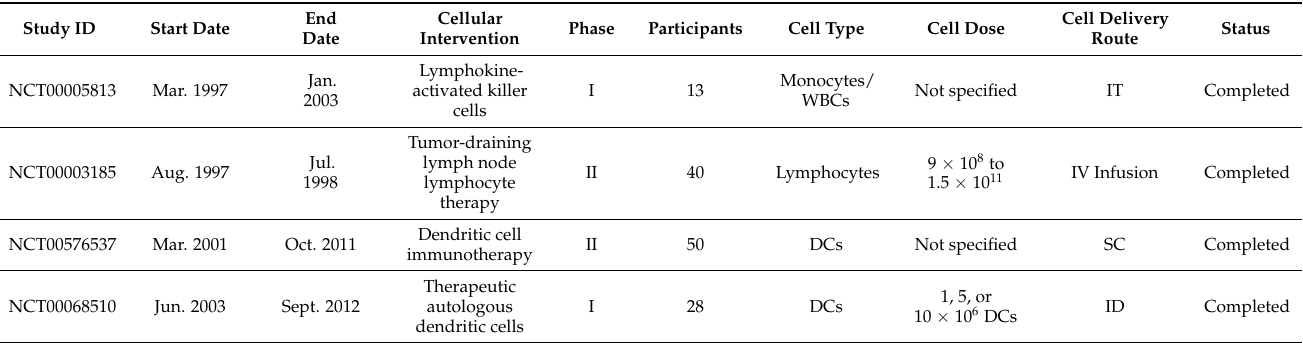
Table 1. Clinical trials on immune cell therapy for